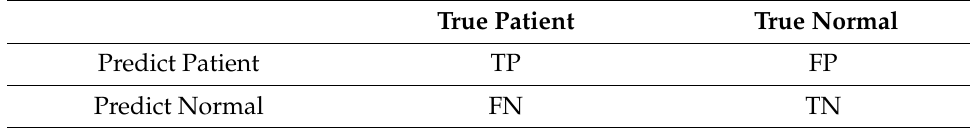
Table 1. Data classification.